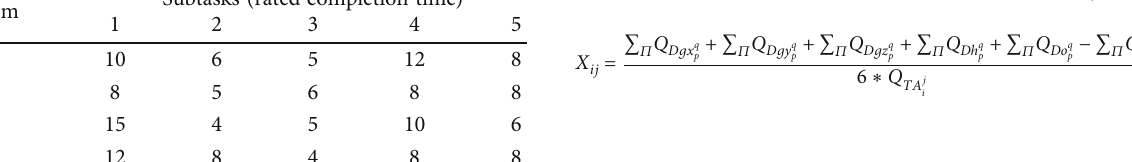
Table 9: Design task-rated completion time. Task item